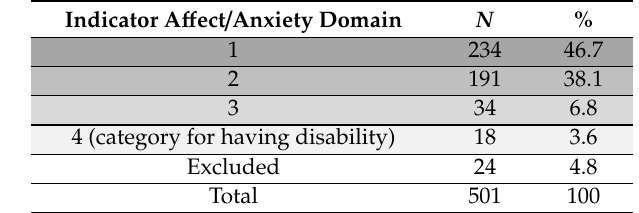
Table 6. Indicator (a ff ect / anxiety domain).